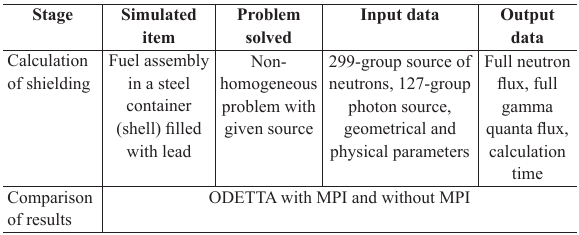
Table 1. Common calculation pattern using the ODETTA code